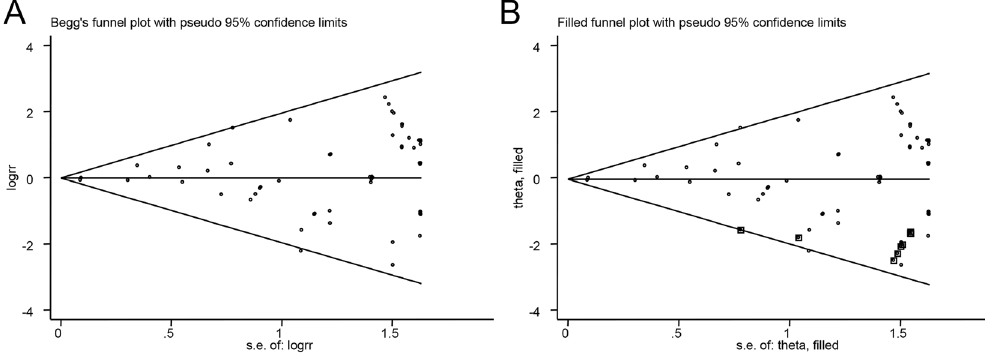
Figure 4. Funnel plot for the analysis of the effect of DPP-4 inhibitors on the risk of cancers. ( A ) Begg’s funnel plot of publication bias for the analysis of the pooled RRs. ( B ) The adjusted funnel plot using Trim and Fill method for publication